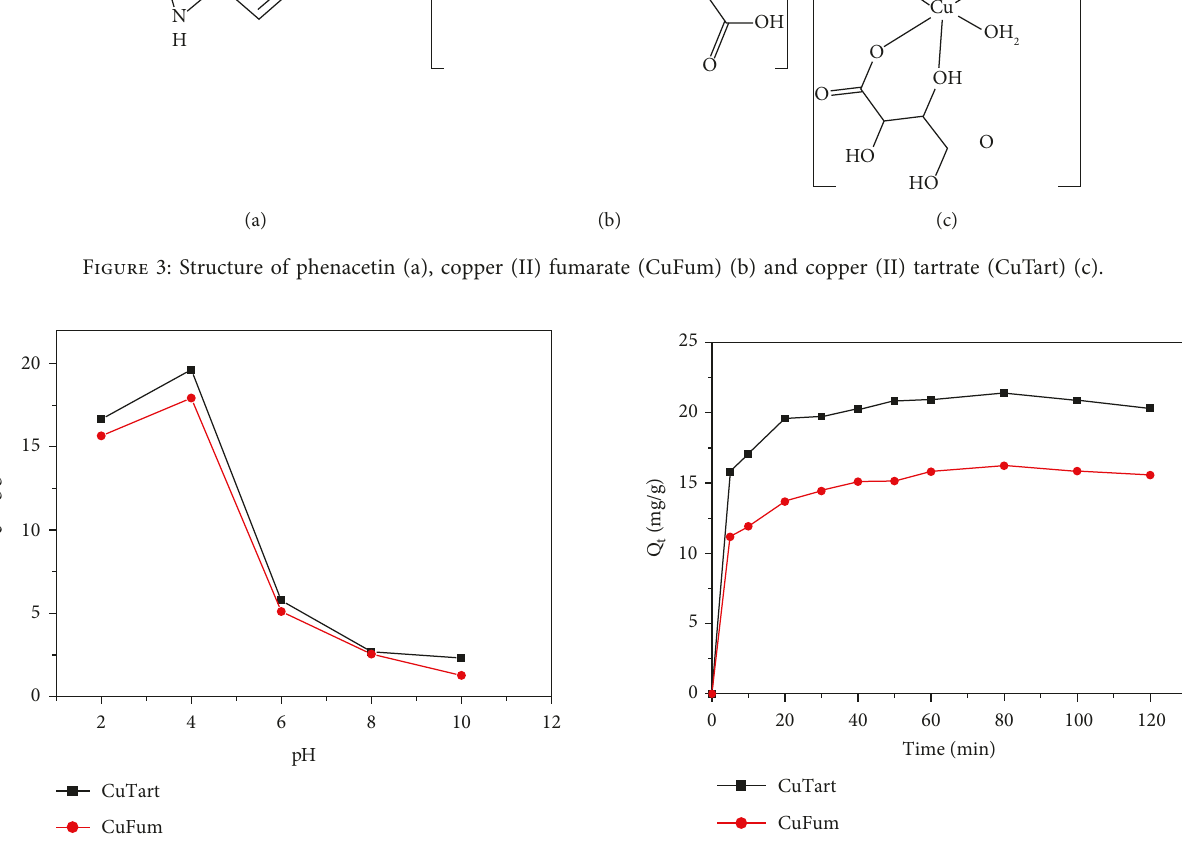
Figure 4: The effect of pH on the adsorption of phenacetin onto CuTart and CuFum.